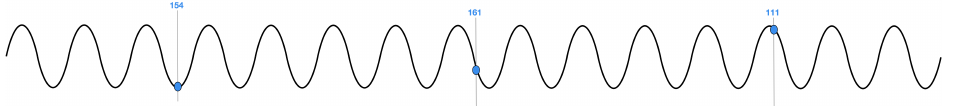
Figure 9. A single transmitter signal shows a different phase when it reaches the antennas at different distances from the source.